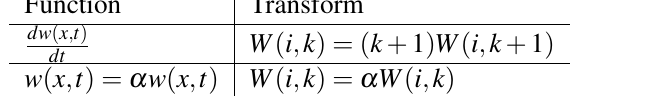
Table 1 Some properties of differential transform based on t − variable.